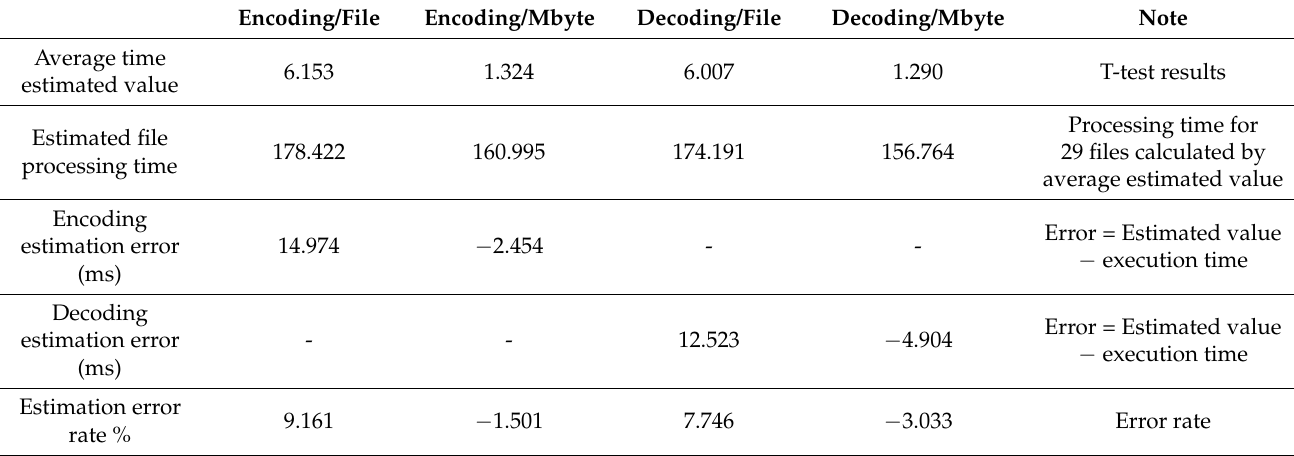
Table 13. Calculation of estimation